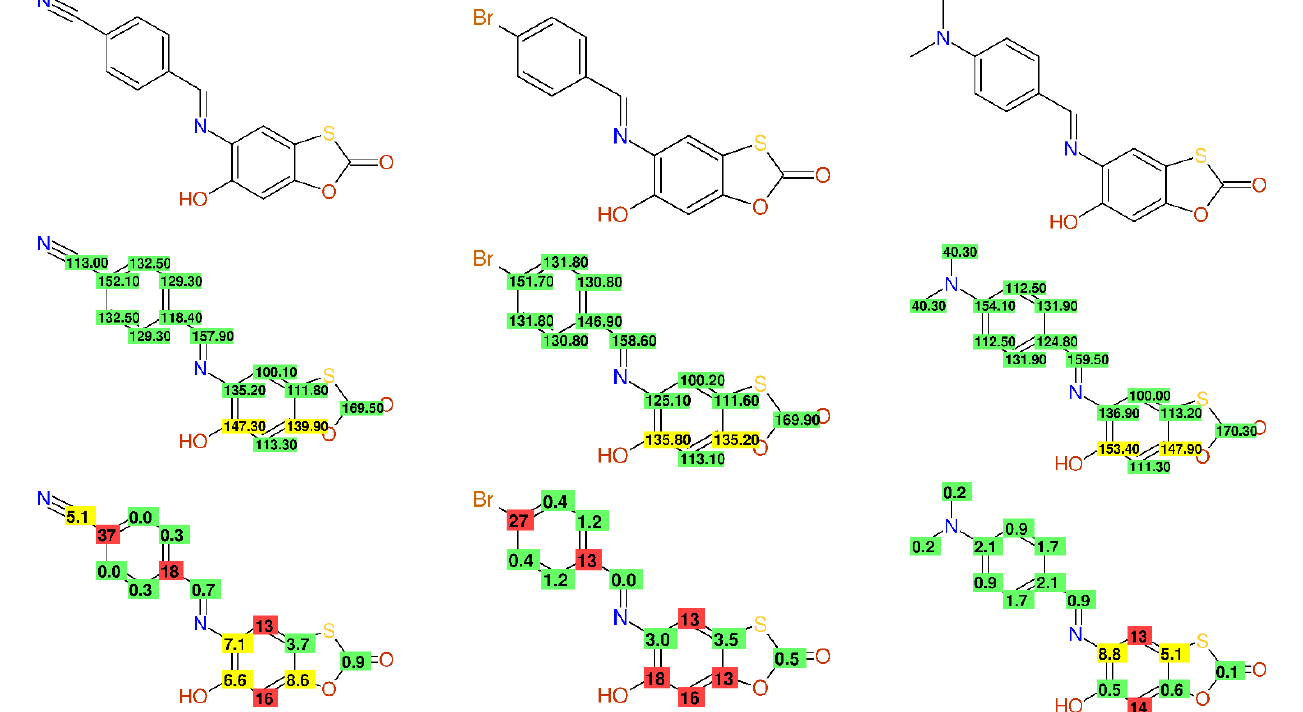
Figure 2. The structures of compound 4a ( left ), compound 4d ( middle ), and compound 4i ( right ) from [35], together with the published 13 C-NMR data and the differences between the experimental and predicted values.